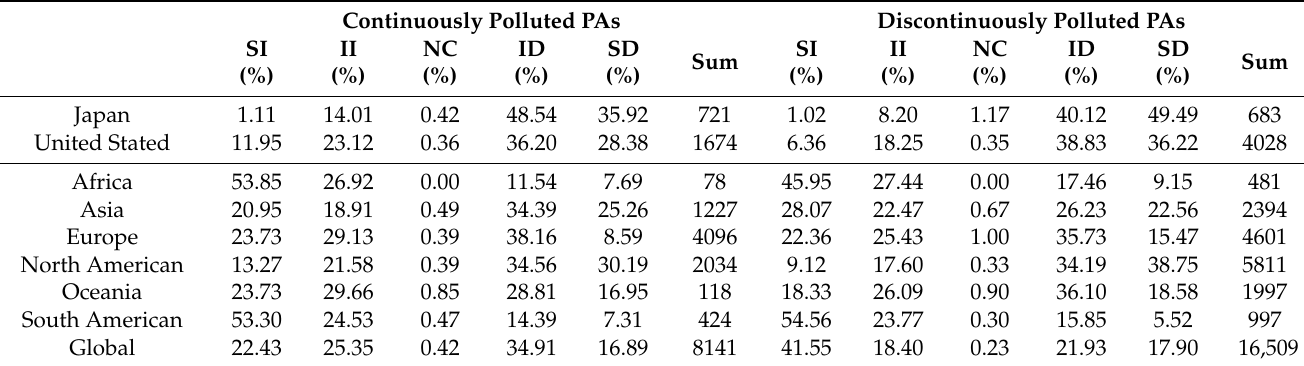
Table 1. The percentage of PAs with different significance levels of the temporal trends of NTL in continuously and discontinuously polluted protected